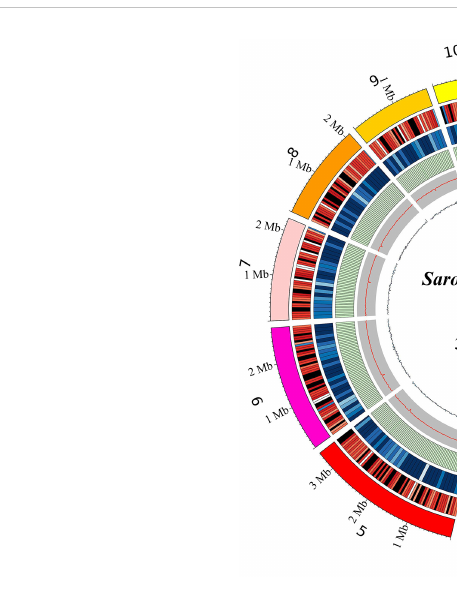
FIGURE 2 Genome features of Sarocladium terricola (RCEF6201). From outer to inner: 1: Genome scaffolds (sorted by length); 2: Gene density (in 50000bp nonoverlapping windows); 3: ncRNA density (in 100000bp nonoverlapping windows); 4: Repeats coverage (in 50000bp nonoverlapping windows); 5: